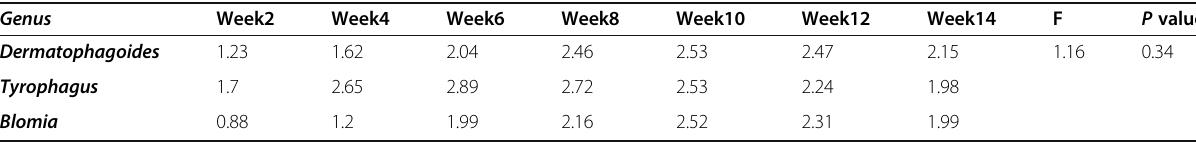
Table 2 Log of cultivated mites counts in mixed cultures and statistical analysis Genus Week2 Week4 Week6 Week8 Week10 Week12 Week14 F P value Dermatophagoides 1.23 1.62 2.04 Tyrophagus 1.7 2.65 Blomia 0.88